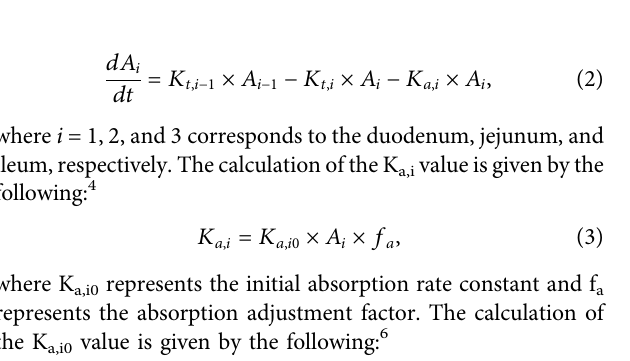
FIGURE1| SchematicrepresentationofthePBPK-DOmodelforsaxagliptininhumans.ThePBPK-DOmodelincludesthegutlumen,enterocytes,theportalvein, the liver, blood (arterial supply and venous return), the lung, and other eliminating tissues (kidney) and non-eliminating tissues (11 compartments). The CYP3A metabolism enzyme was set into enterocytes and liver compartments. DPP-4 was assumed to only reside in the venous return